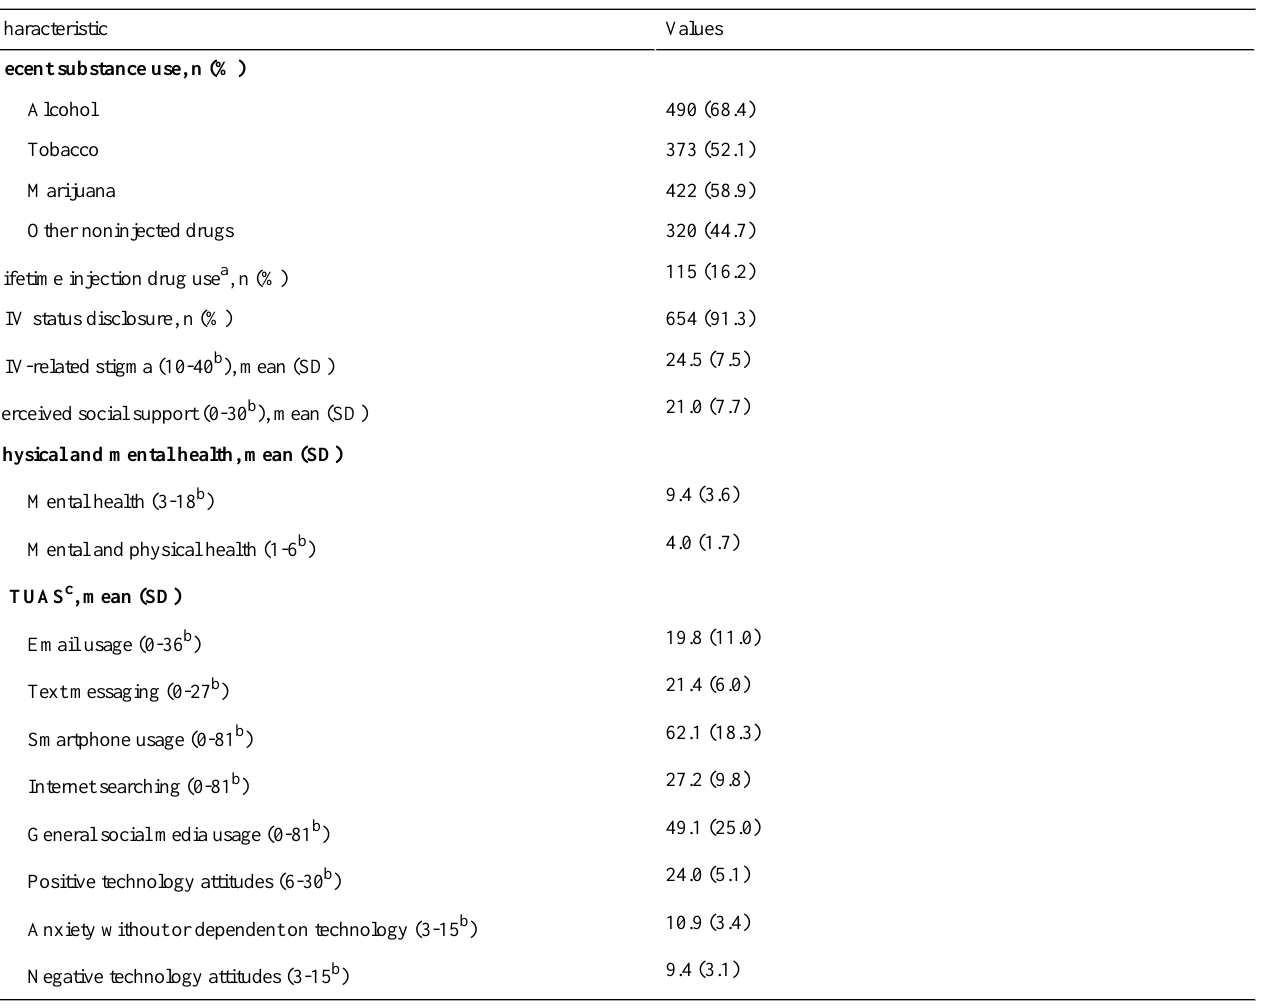
Table 2. Substance use, HIV-related disclosure and stigma, physical and mental health, and Media and Technology Usage and Attitudes Scale measures entered into lasso models as internet health-seeking